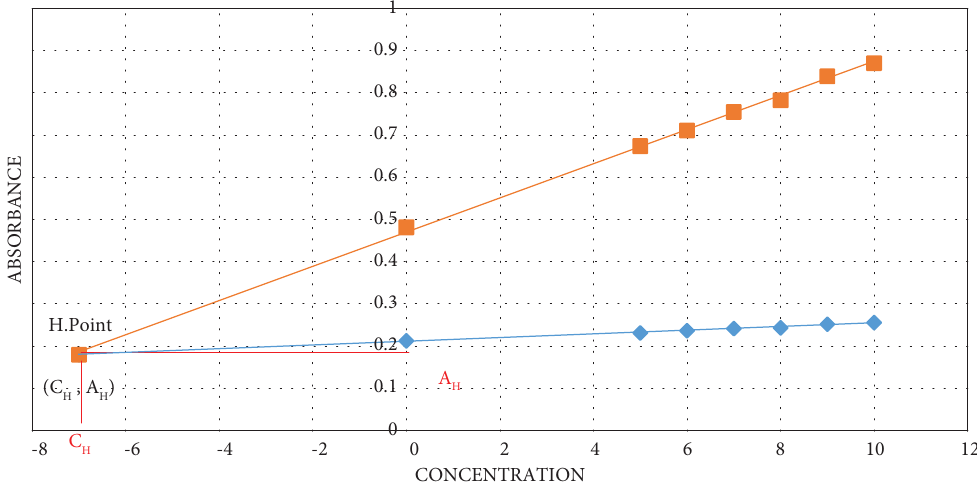
Figure 2: H -point standard addition method.